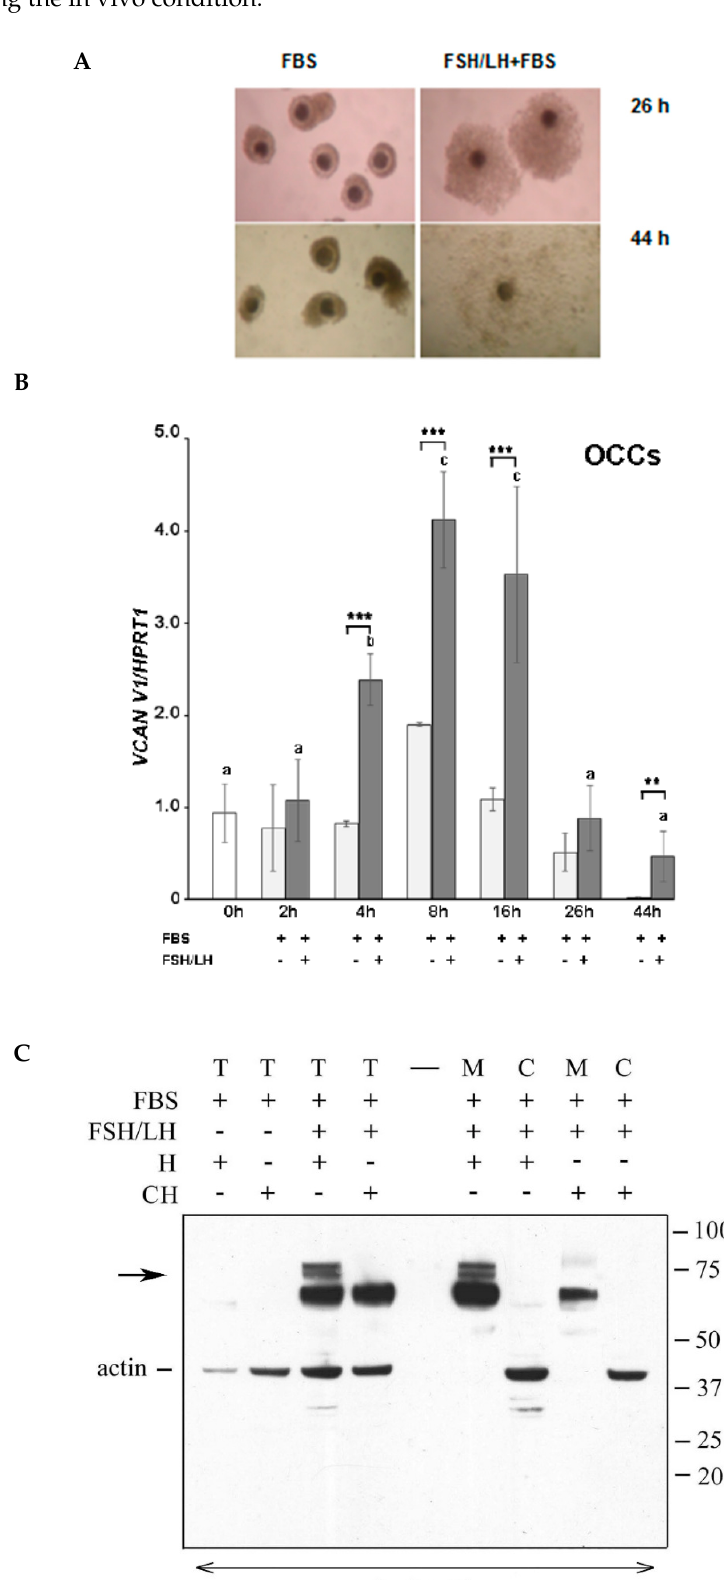
Figure 2. E ff ects of gonadotropins on cumulus expansion and versican expression Figure 2. Effects of gonadotropins on cumulus expansion and versican expression oocyte-cumulus complexes (OCCs) cultured in vitro. ( A ) Morphology of OCCs stimulated with gonadotropins (100 ng/mL follicle-stimulating hormone (FSH) + 100 ng/mL luteinizing hormone (LH)) cultured in vitro for 26 and 44 h in medium supplemented with 5% FBS. Note that the size of OCCs cultured in the presence of gonadotropins was larger than that of OCCs cultured only in basal medium (FBS alone). Full expansion was reached at 44 h when cumulus cells became scattered in an abundant extracellular matrix (ECM). ( B ) Versican V1 mRNA ( VCAN V1 ) expression investigated by RT-PCR in hormone- stimulated OCCs cultured in vitro. Groups of 30 OCCs were immediately processed (0 h; white bar) or cultured in FBS-supplemented medium without (light grey bars) or with (grey bars) FSH/LH stimulation, as above, for the indicated time points. Three independent experiments were performed. Bars show means ± SEM. In the time course of gonadotropin-stimulated OCCs; different superscripts (a–c) indicate statistically significant differences compared to 0 h sample ( p < 0.05). Asterisks indicate